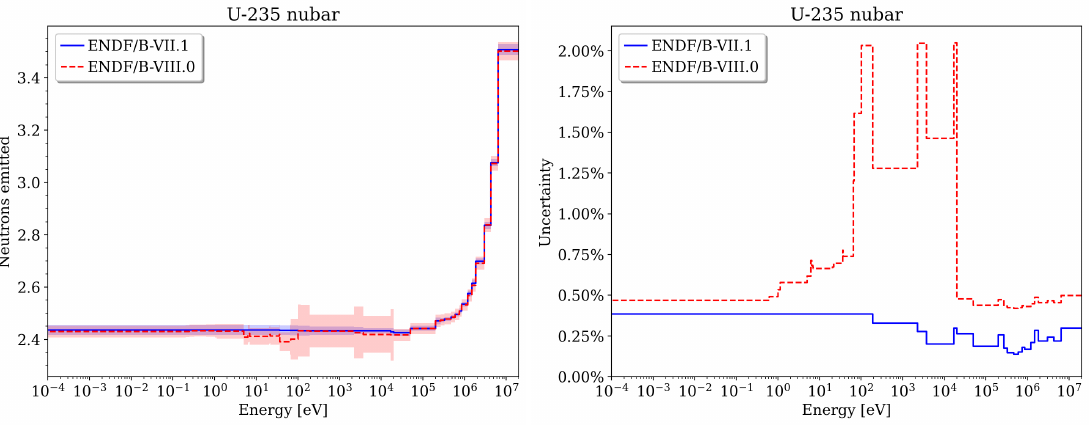
Figure A7. 235 U ν nominal data and uncertainty.